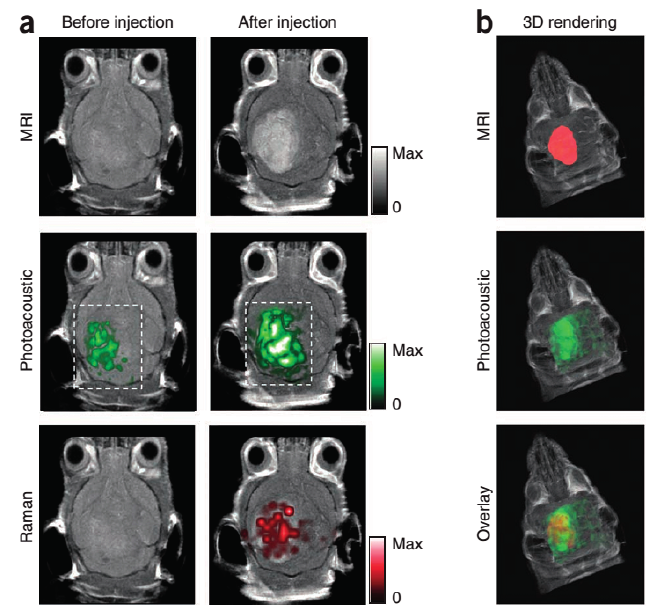
Figure 6. Triple-modality detection of brain tumors in living mice with MPRs. ( a ) Two-dimensional axial MRI, photoacoustic and Raman images. The post-injection images of all three modalities showed clear tumor visualization (dashed boxes outline the imaged area); ( b ) A three dimensional (3D) rendering of magnetic resonance images with the tumor segmented (red; top ), an overlay of the three-dimensional photoacoustic images (green) over the MRI ( middle ) and an overlay of MRI, the segmented tumor and the photoacoustic images ( bottom ) showing good colocalization of the photoacoustic signal with the tumor. (Reprinted from reference [52]. Copyright with permission from © 2012, Rights Managed by Nature Publishing